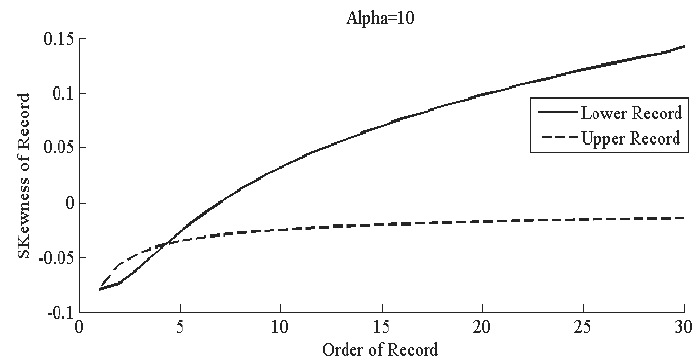
Figure 15 – Skewness coefficient of